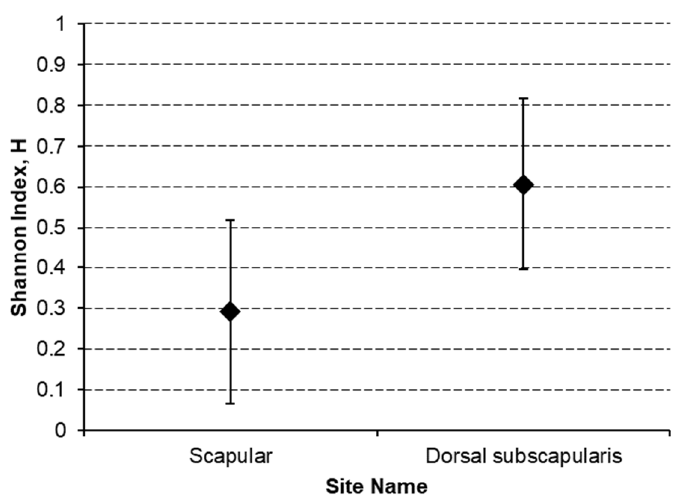
Figure 6. Lymphatic laterality heterogeneity comparison.